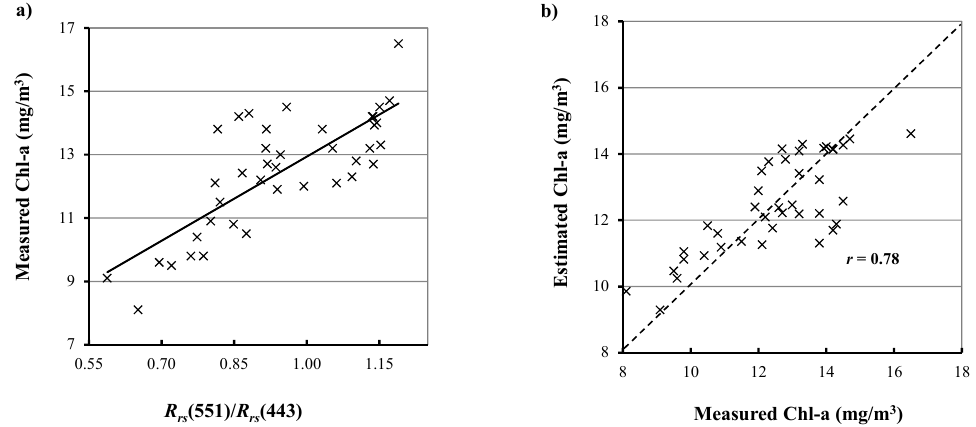
Figure 2. ( a ) The relationship between chlorophyll-a (Chl-a) concentration of the water sample and the ratio of two reflectances at MODIS Band 12 (551 nm) vs. Band 9 (443 nm). A regression line is drawn to show the relationship. ( b ) Scattergram of Chl-a concentrations between the sample value and estimation by the ratio of green and blue band reflectance (rGBr) of Equation (17). The 45-degree dotted line denotes perfect estimation.